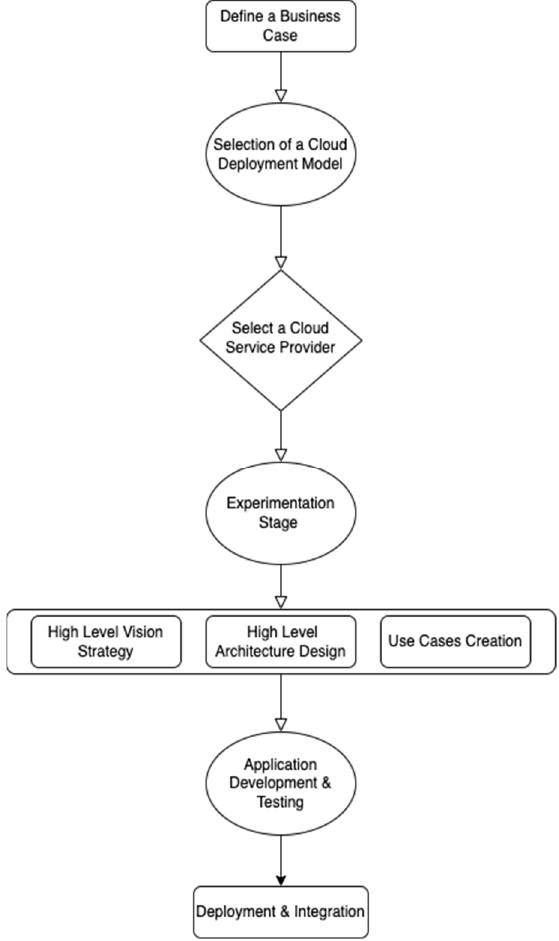
Figure 23. Blockchain–Cloud Adoption Journey.